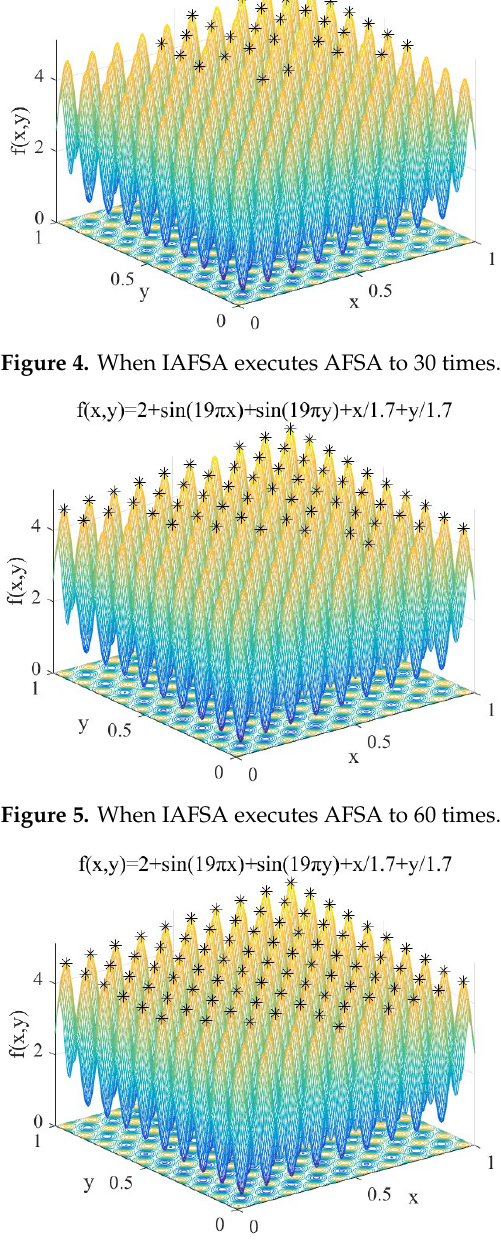
Figure 7. When IAFSA executes AFSA to 120 times.